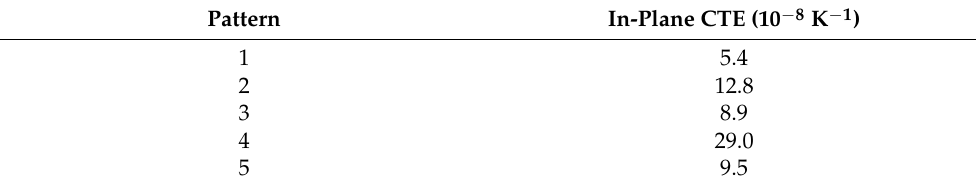
Table 2. The in-plane coefficient of thermal expansion of designs of the 2 × 1 × 2 lattice. Pattern